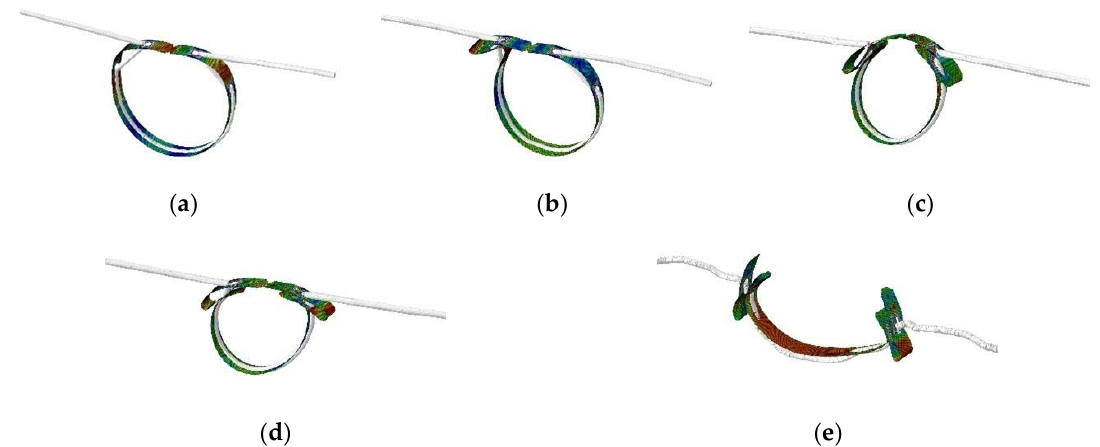
Figure 8. Three-dimensional behavior of steel rings during different phases, ( a ) primary elastic buckling; ( b ) local buckling on left shoulder; ( c ) local buckling on right shoulder; ( d ) secondary elastic buckling; and ( e ) tensile failure.